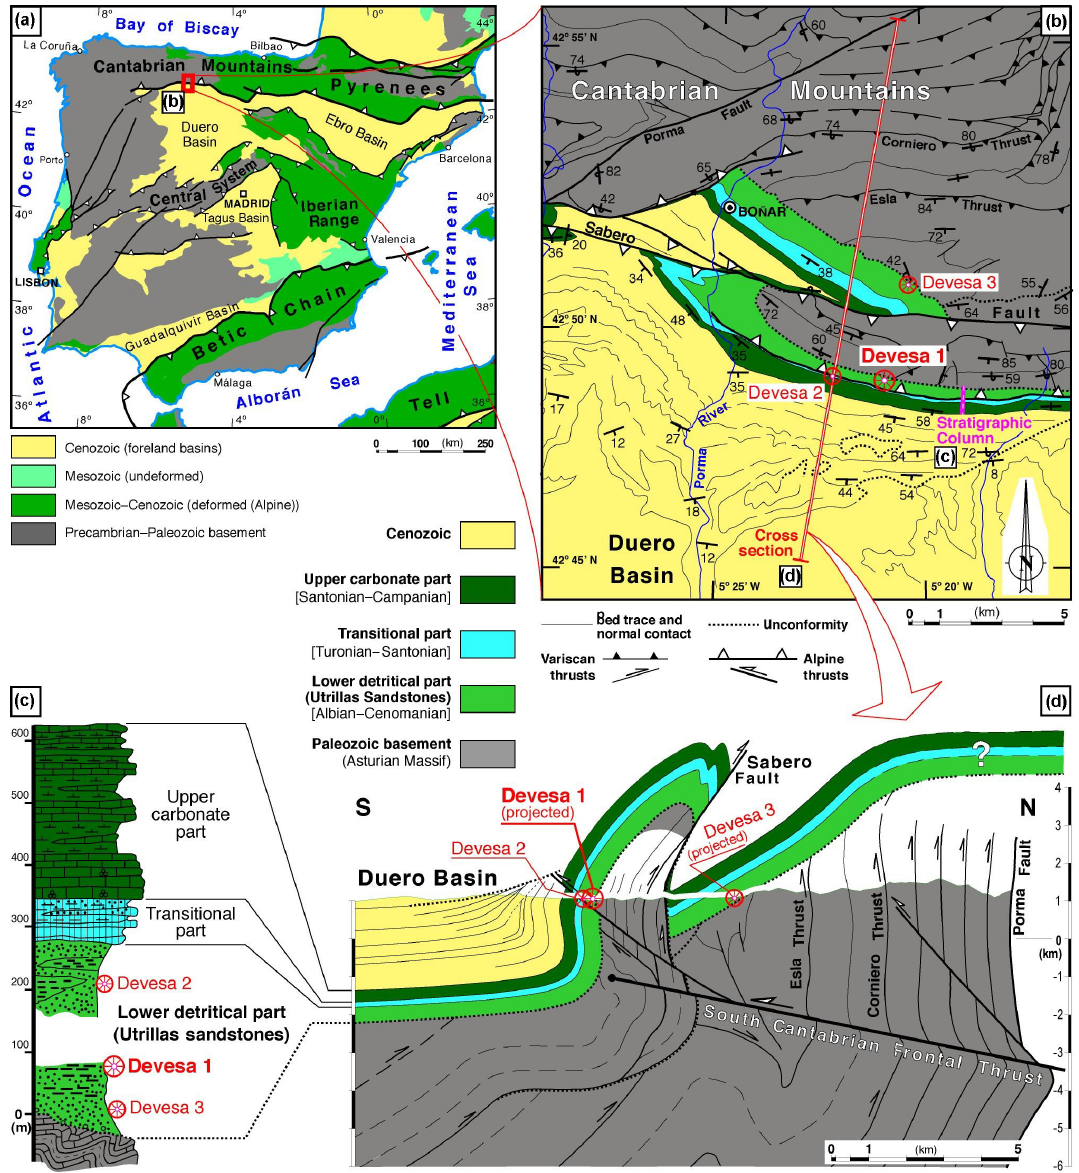
Figure 2. (a) Location of the studied area in northern Spain; modified from Quintana et al. (2015) (b) Geological map and location of the sampling areas modified from Lobato et al. (1985), Manjón Rubio et al. (1982b) and Alonso et al. (1996). (c) Stratigraphic column of the Cretaceous succession of the studied area. Location in (b) . Manjón Rubio et al. (1982b). (d) Geological cross-section along the sampling areas: boundary between the Cantabrian Mountains and the Duero Basin. The geometry of the South Cantabrian Frontal Thrust and of the Cenozoic materials of the Duero Basin taken from Alonso et al. (1996). Location in (b)